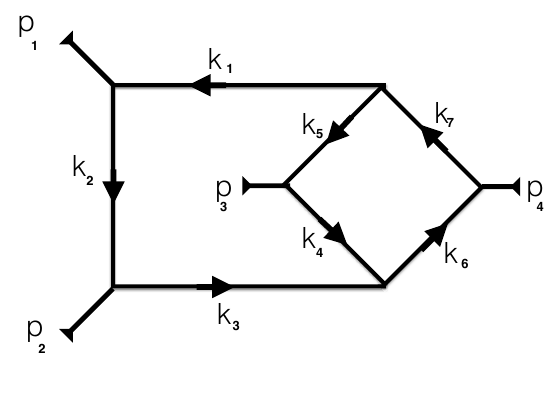
Figure 9 . The two-loop